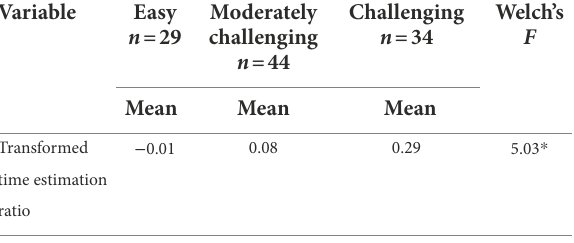
TABLE 3 One-way ANOVA comparing transformed time estimation ratios based on reported difficulty of previous academic task. Variable